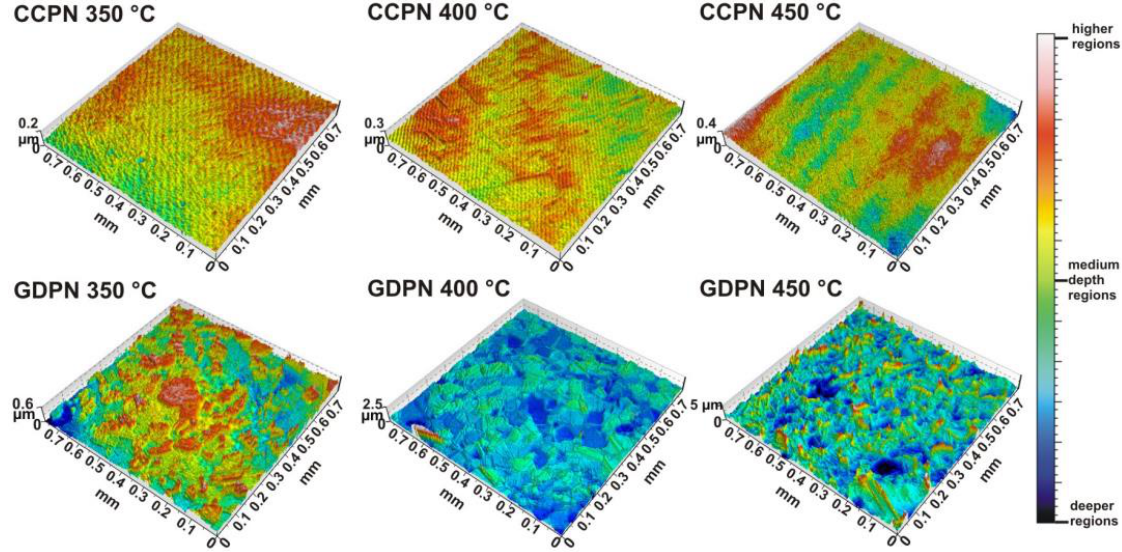
Figure 2. Surface microstructures of samples nitrided by CCPN and GDPN, obtained by OI. Table 1. The thickness of modified layers and films, roughness, and hardness of the untreated and nitrided